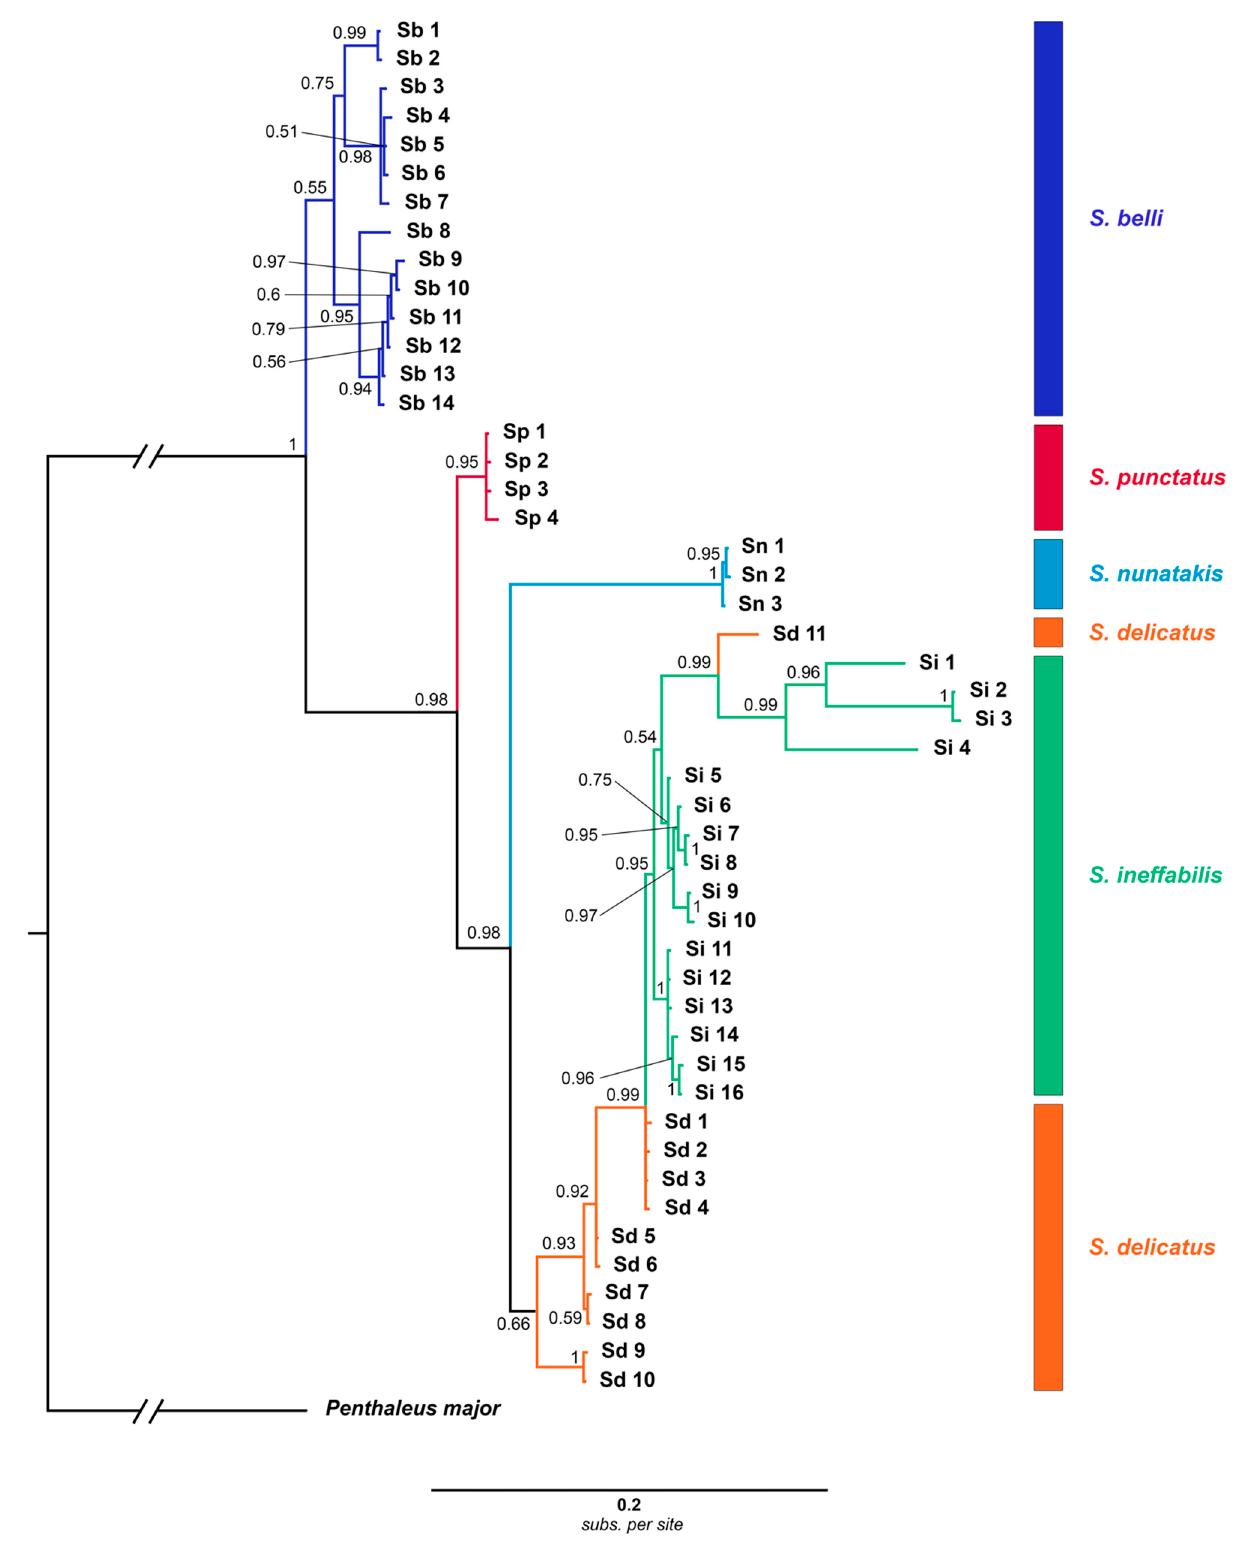
Figure 5. Phylogenetic tree of the combined mitochondrial and nuclear sequences of Stereotydeus specimens from Victoria Land. Posterior probabilities are shown at the nodes; labels indicate the ID of the haplotypes. For detailed description of haplotypes, see Table 5 .